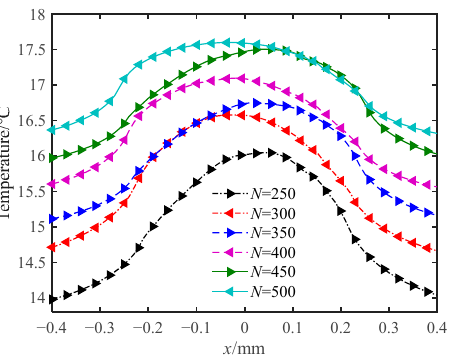
Figure 10. Variation pattern of temperature distribution with the number of cycles.